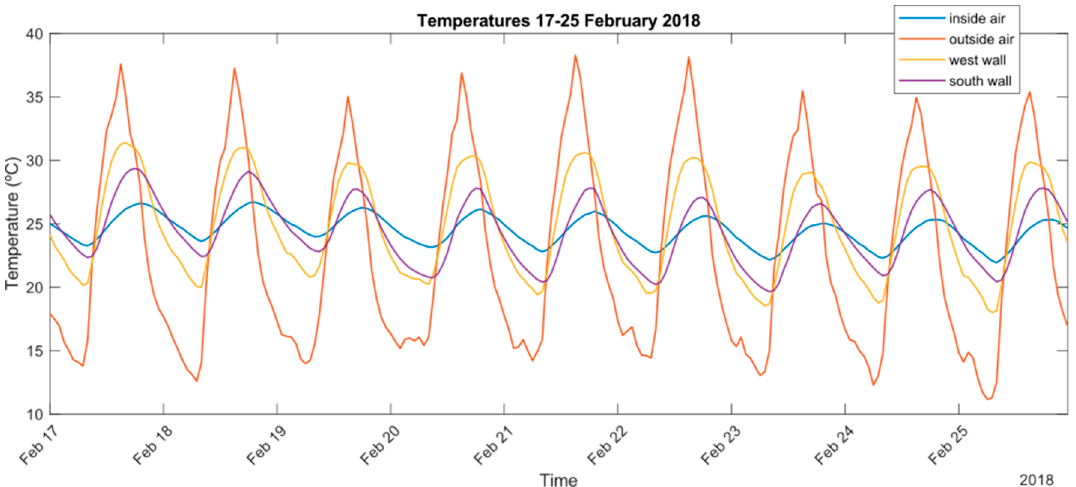
Figure 7. Real temperature data from February 17th to 25th 2018.